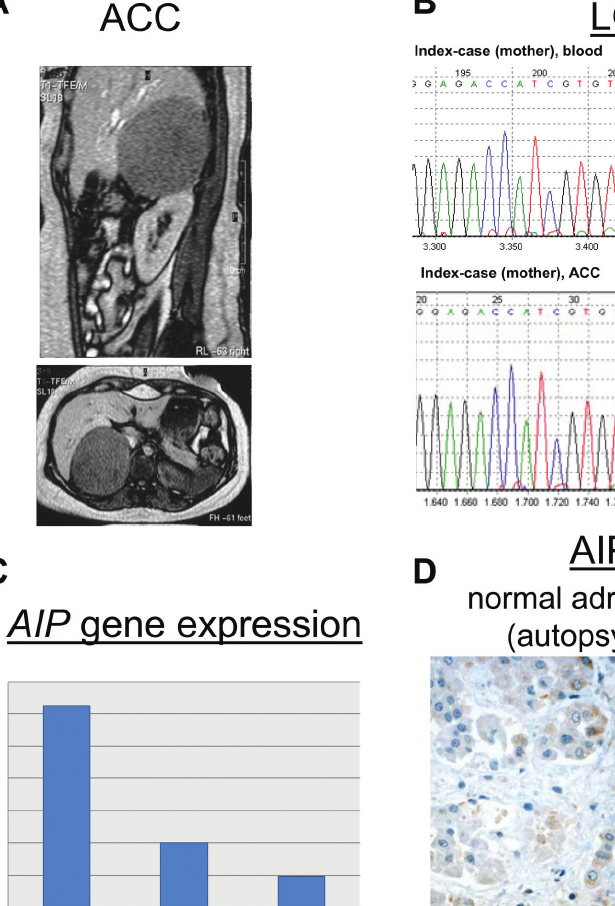
by comparison, there was decreased AIP expression in the adrenocortical carcinoma (0.48). D - Immunohistochemistry using the AIP antibody showed low/ moderate staining in a normal adrenal gland obtained from autopsy. A complete loss of AIP immunoreactivity was observed in the adrenocortical carcinoma from the index patient, which stained positive for Melan A and 35betaH11, which were used as positive